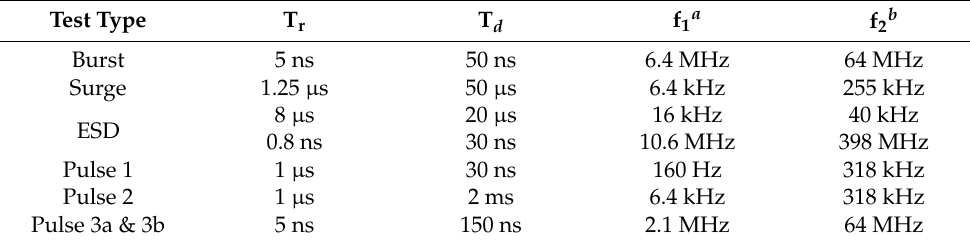
Table 1. Rise-time and duration times for disturbance signals frequency spectrum calculations.